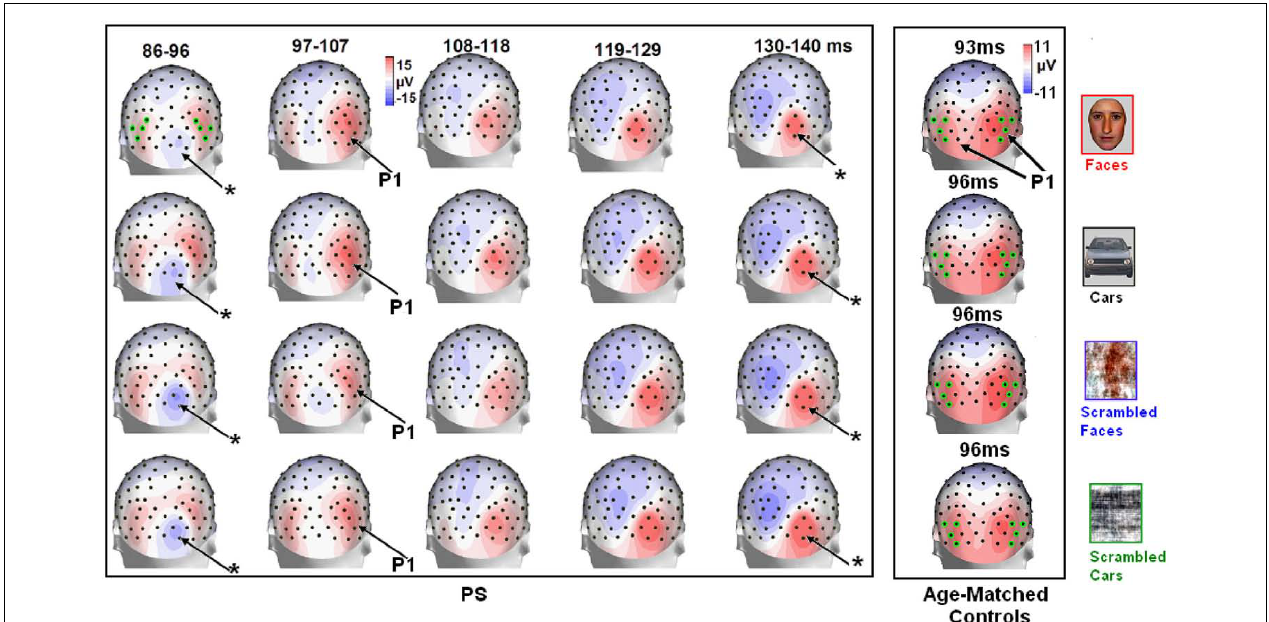
130–140ms).These unusual components (indicated in the figure with an asterisk) were most prominent before and after the lateral P1 component. The P1 topography (at the latency at which the component reached its highest amplitude) for the age –matched controls is also shown for